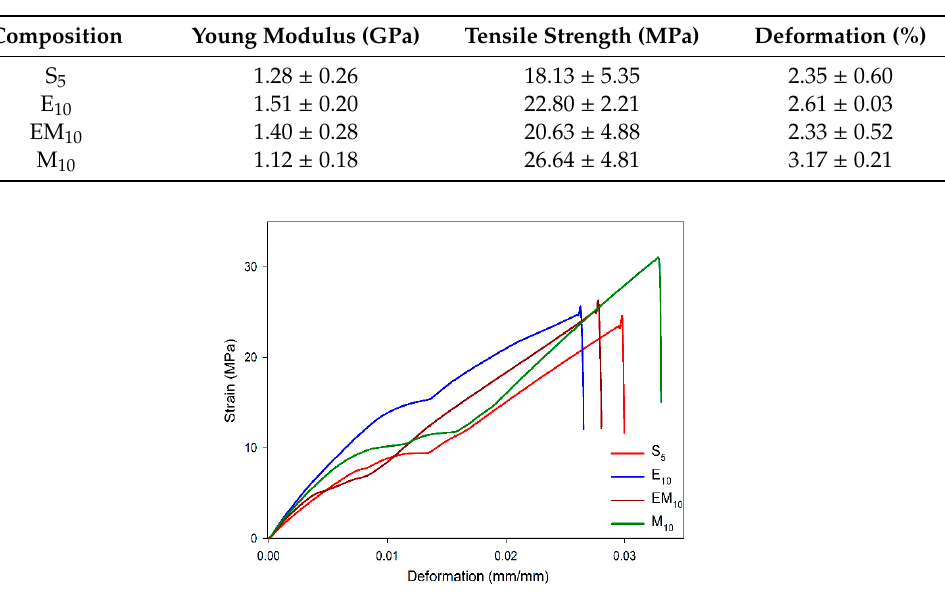
Table 6. Tensile properties of epoxy / eggshell compounds.